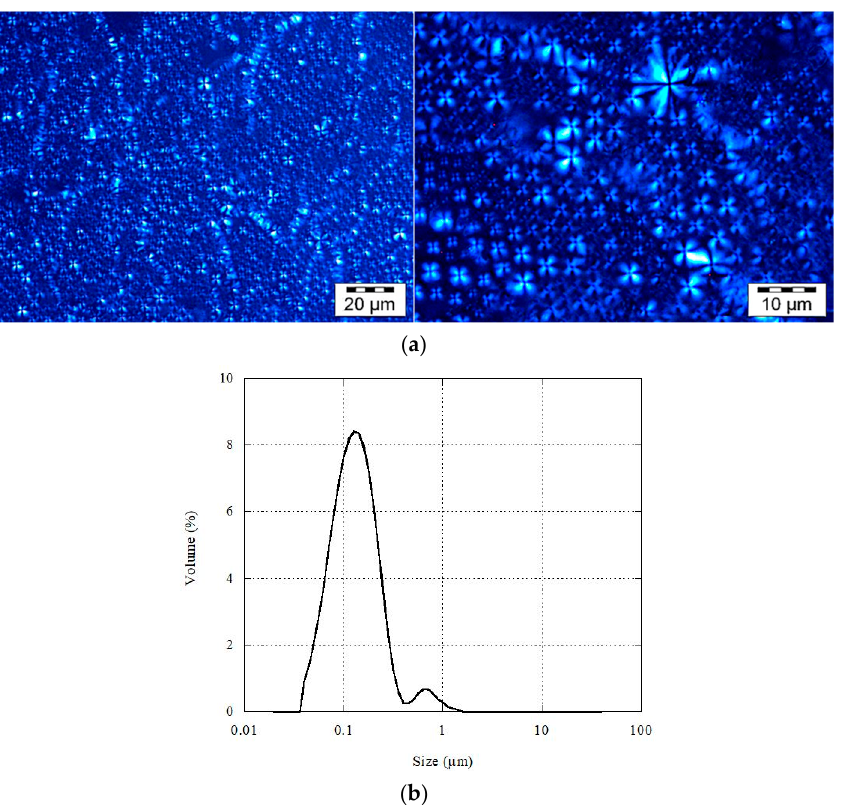
Figure 1. ( a ) Images of multi-lamellar liposomes (MLLs) after shearing observed under polarized light, and ( b ) their size distribution when dispersed in water.